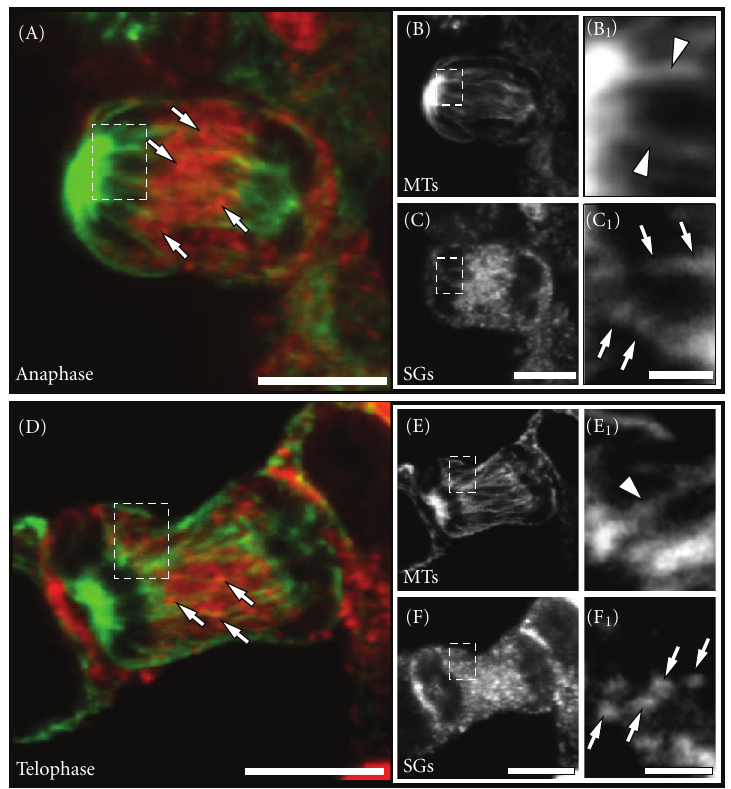
Figure 5: Distribution of SGs during late stages of mitosis. Single confocal planes of immunostained PC12 cells in anaphase ((A)-(C 1 )) and telophase ((D)-(F 1 )) are shown as indicated. Note that the majority of SGs during anaphase and telophase was found in the cell midzone ((A) and (D), arrows). A pronounced decoration of spindle microtubules ((E 1 ) and (F 1 ), green arrowheads) with SGs ((E 2 ) and (F 2 ), arrows) was frequently observed during these late stages of mitosis. Scale bars ((A), (C), (D), (F)), 5 μ m; ((C 1 ), (F 1 )), 1 μ